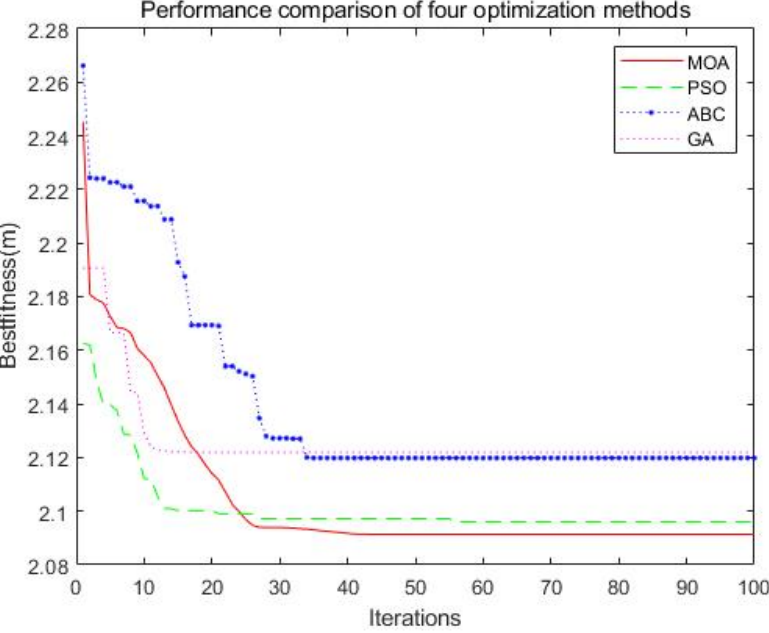
Figure 3. Iterative convergence process of four optimization algorithms for fitness function. Table 1. Optimized results of the four algorithms under scenario 1. 1